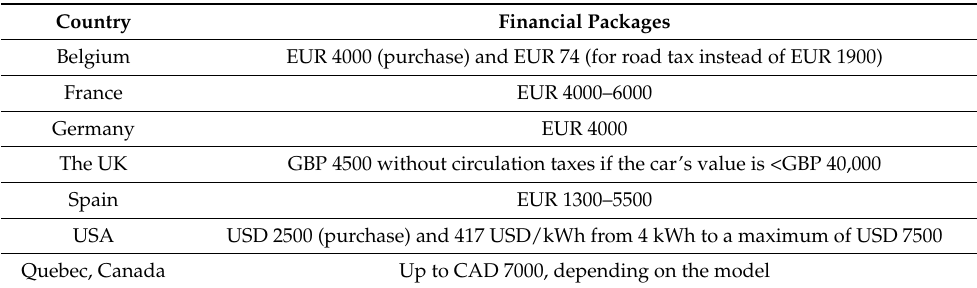
Table 9. Countries and financial incentives for the purchase of